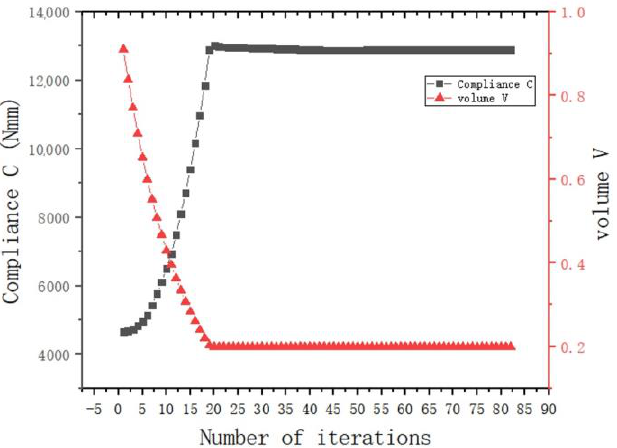
Figure 9. Optimization process under the condition of axial force (the black dotted line is the change curve of compliance C, and the red dotted line is the volume-reduction curve).